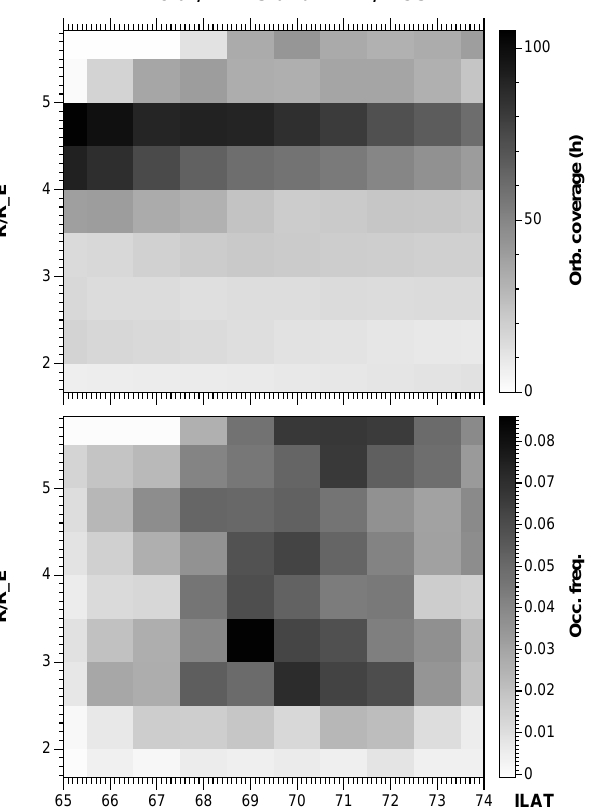
Fig. 7. Top: Orbital coverage in hours in each bin. Bottom: Occur- rence frequency of all nightside 0.5–10keV ion beams as a function of ILAT and radial distance R . Both TIMAS and EICS data are put together, as are all K p values, all nightside MLT sectors (18–06), and sunlit and darkness